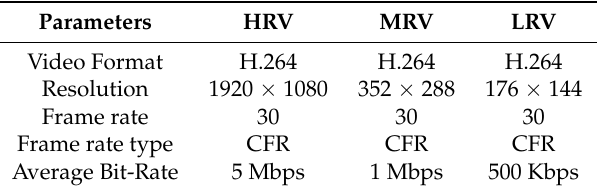
Table 4. Parameters set for H.264